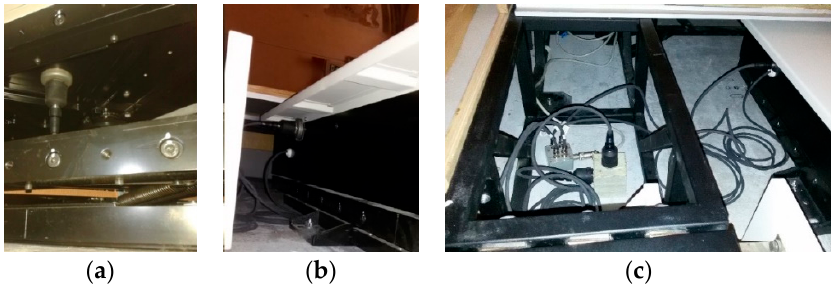
Figure 2. The positions of the accelerometers: ( a ) on the upper plate in the vertical direction; ( b ) on the upper plate in the horizontal direction; and ( c ) on the ground plate in both directions. Table 1. Specifications of sensor and acquisition system.